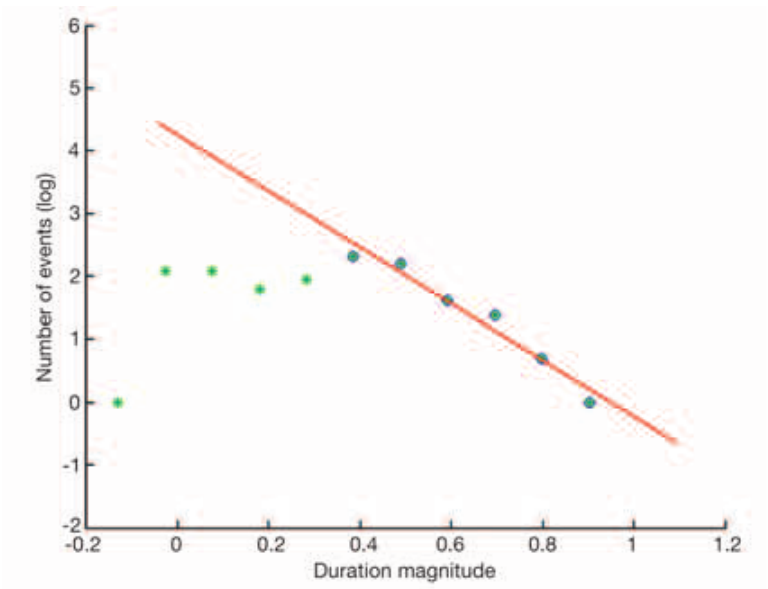
Fig. 8. Minimum magnitude of completeness M events versus magnitude and the straight line that fit the data.